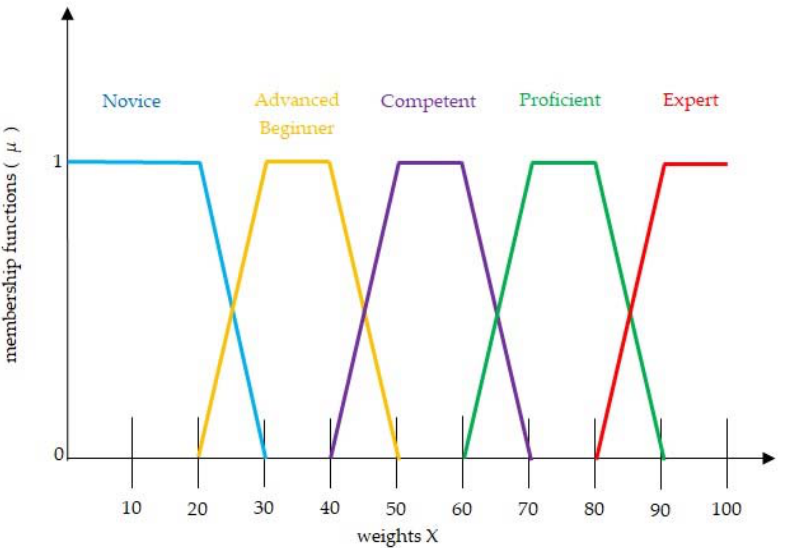
Figure 1. Linguistic scales and fuzzy weights numbers of current knowledge level.